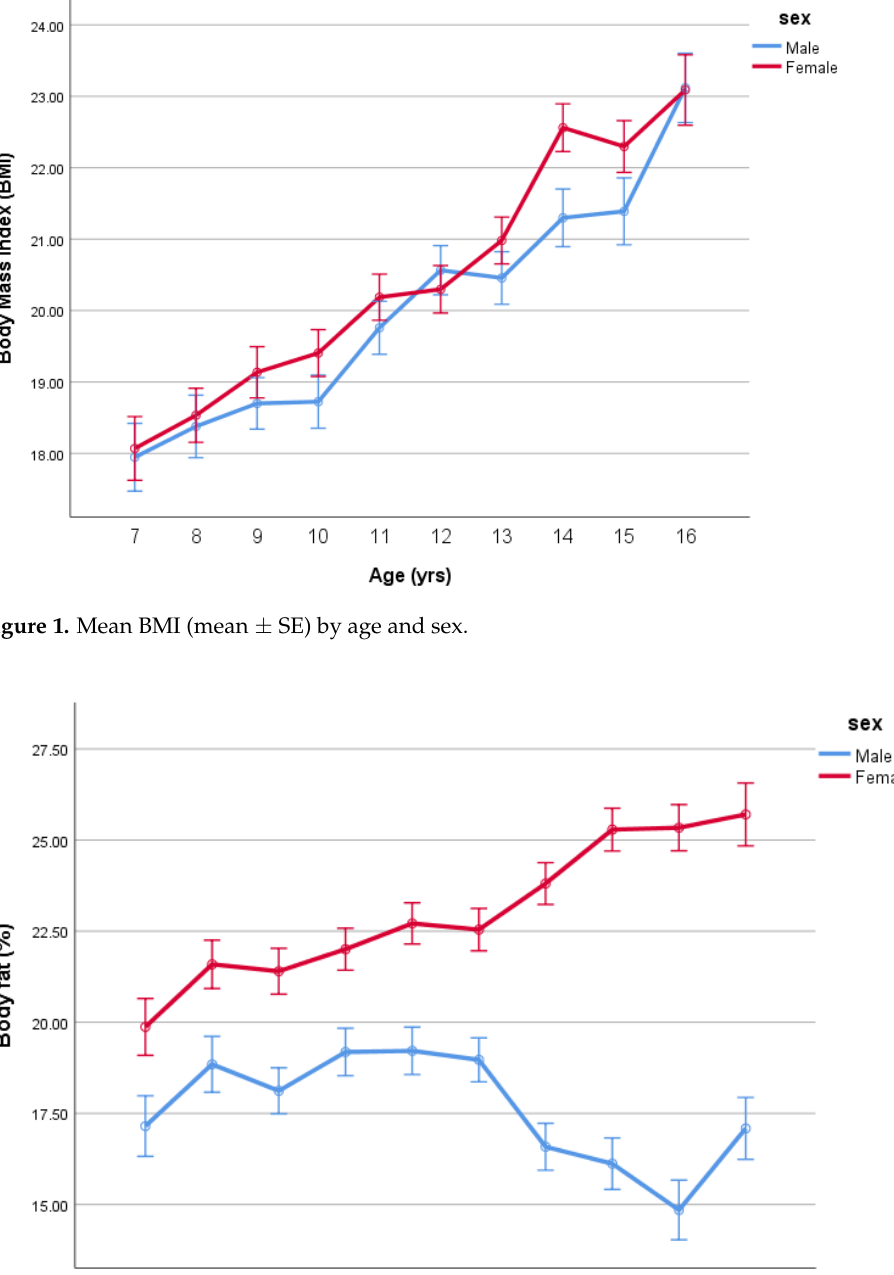
Figure 2. Body fat percentage (BF%) (mean ± SE) by age and sex.